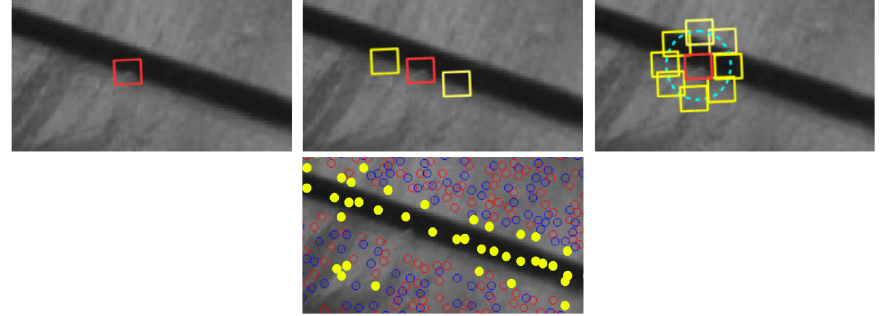
Figure 10. An example of non-repetitive patterns